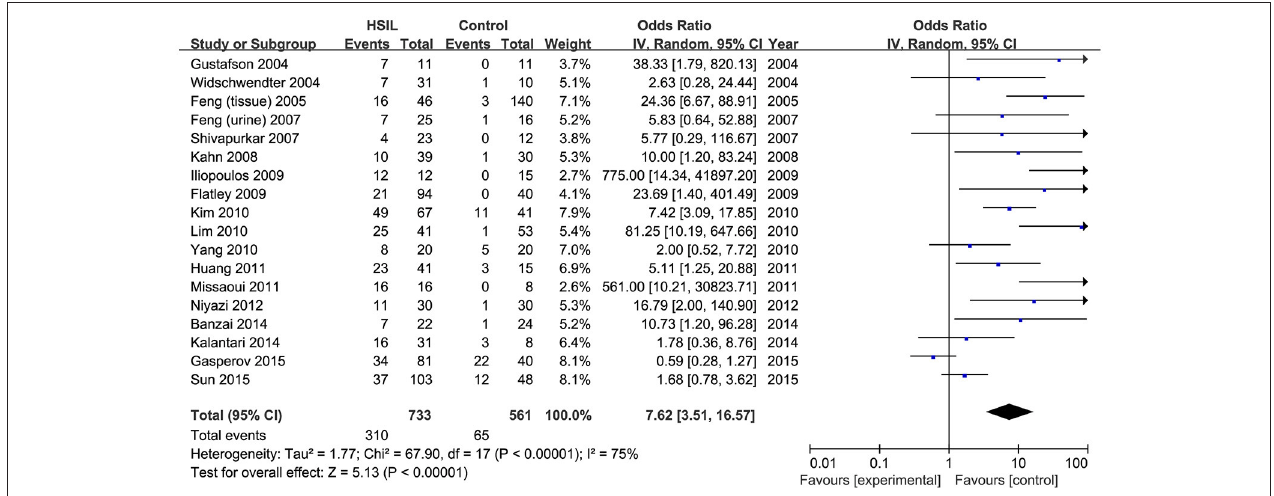
FIGURE 3 | Funnel plots for the associations of DAPK1 promoter hypermethylation with the risk of HSIL. HSIL, high-grade intra-epithelial lesion.